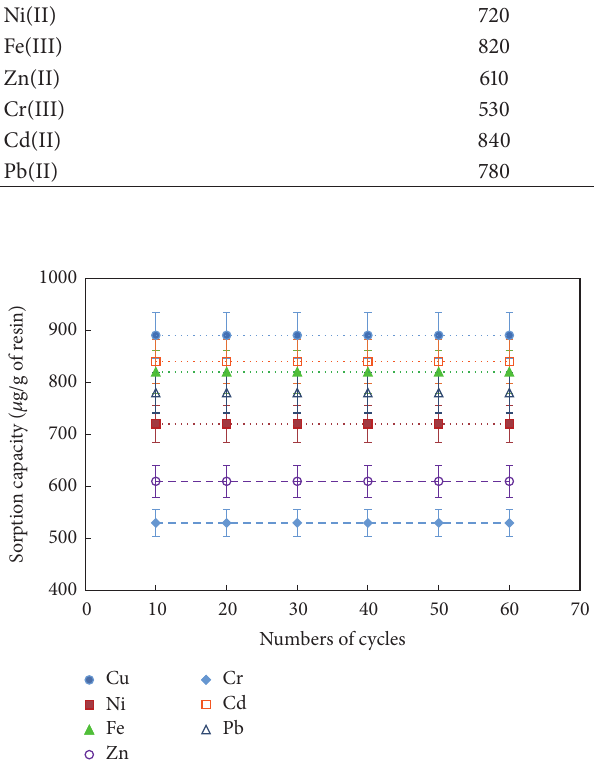
Figure 4: The effect of column reuse on recovery of metal ions by Amberlite XAD-7 resin at optimum